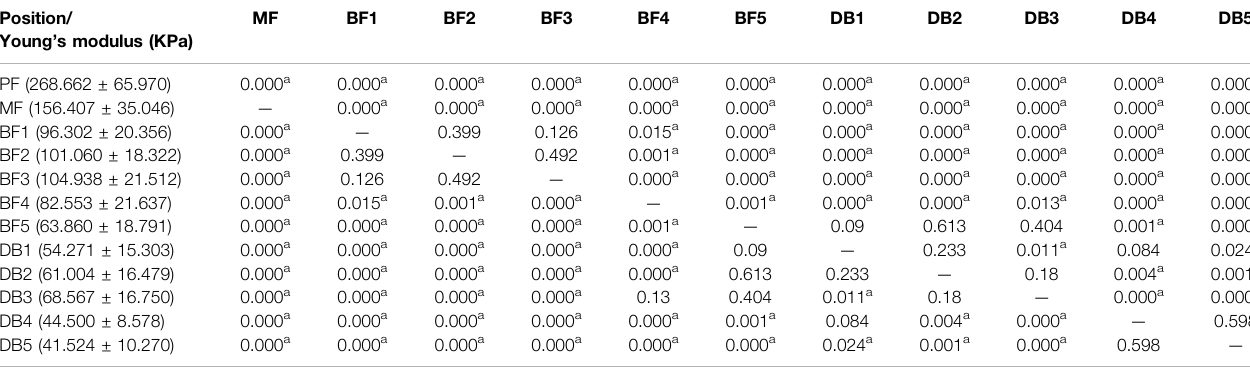
TABLE 3 | P value of least signi fi cant difference results between different positions in Young ’ s modulus of plantar fascia. Position/ Young ’ s modulus (KPa)